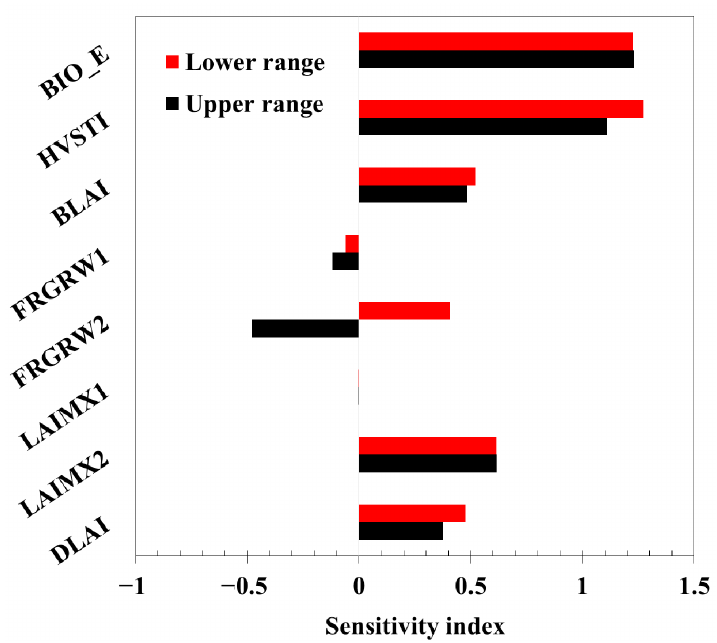
Figure 2. Comparison of the evaluations of sensitivity indices for the eight parameters within the upper ( ■ ) and lower ( ■ ) ranges shown in Table 1. upper ( (cid:4) ) and lower ( (cid:4) ) ranges shown in Table 1.